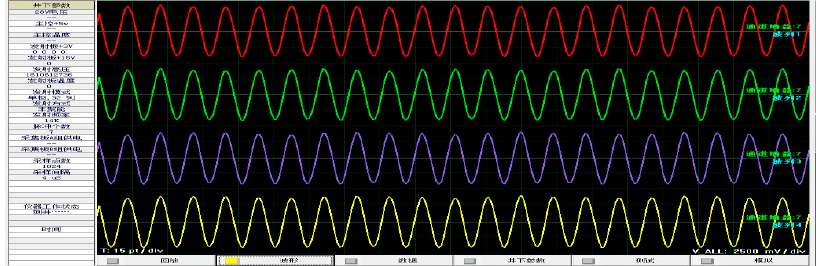
Figure 14. Test waveforms of the data track of the circumferential transducer.